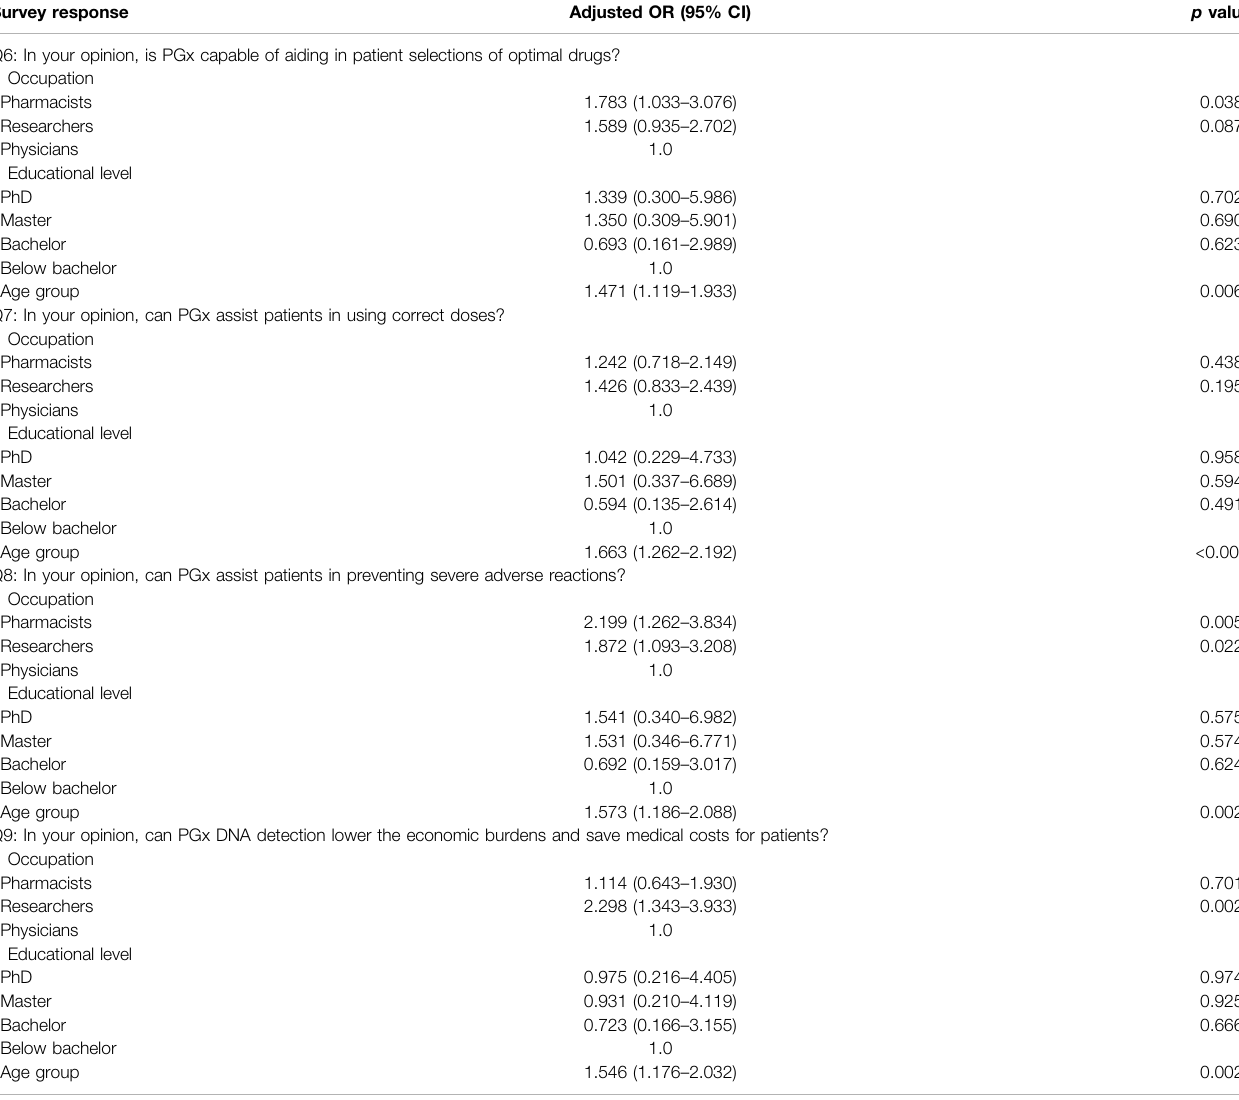
TABLE 3 | Awareness of PGx (multivariate logistic